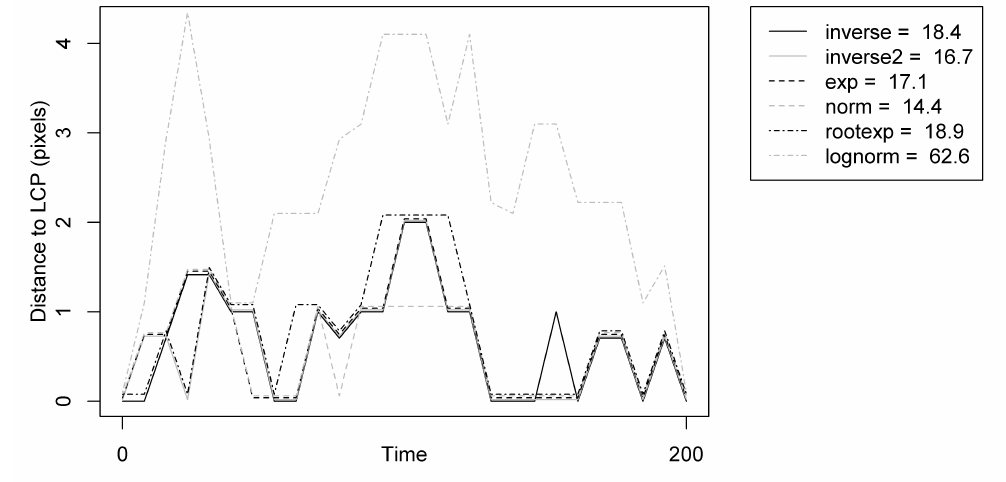
Figure 6: Distance (number of pixel units) of the location of maximum probability ( l t ) from the shortest time path for each of the six potential functions (see Table 3.1) using the field- based time geography model applied to Scenario